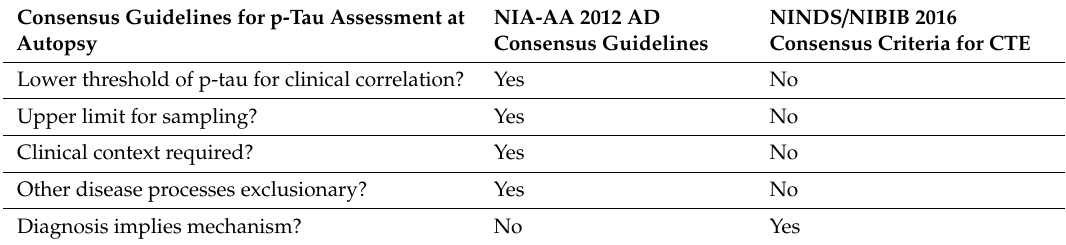
Table 4. Contrasts between NIA-AA 2012 (AD) and NINDS / NIBIB 2016 (CTE)